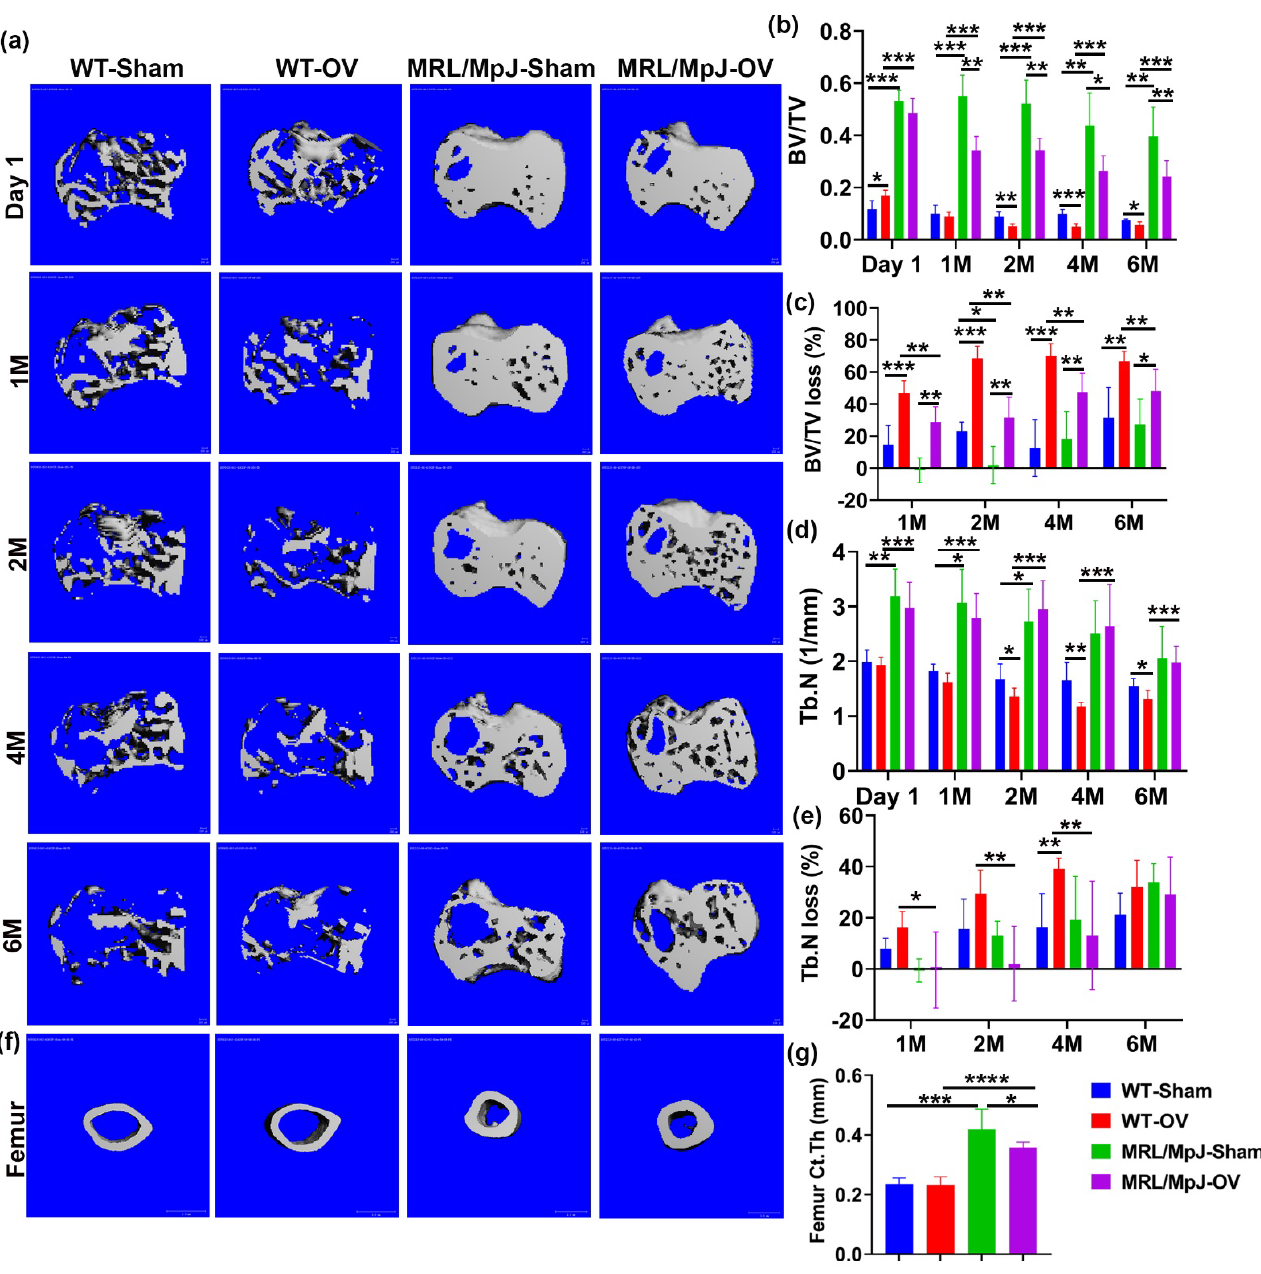
Figure 6. Micro-CT analysis of proximal tibia trabecular bone and femoral cortical bone. ( a ) Micro-CT 3D images of the proximal tibia over the course of 6 months. WT-OV mice demonstrated obvious trabecular bone loss at 1 month compared to day 1 after surgery and continued bone loss until 6 months, at which point almost no trabecular bone remained. WT-Sham mice also demonstrated bone loss at 6M. MRL/MpJ-OV also demonstrated bone loss during the 6M period after ovariectomy but to a much lesser extent. Markedly higher bone mass was maintained during this process for both MRL/MpJ-OV and MRL/MpJ-Sham. Scale bars = 100 µm. ( b ) BV/TV. At day 1, BV/TV was significantly higher in WT-OV than WT-Sham mice. At 2M to 6M, the BV/TV in the WT-OV group was significantly lower than that of the WT-Sham group. The MRL/MpJ-OV group demonstrated decreased BV/TV when compared to the MRL/MpJ-Sham group at the 1 M, 2 M, 4 M, and 6 M timepoints.